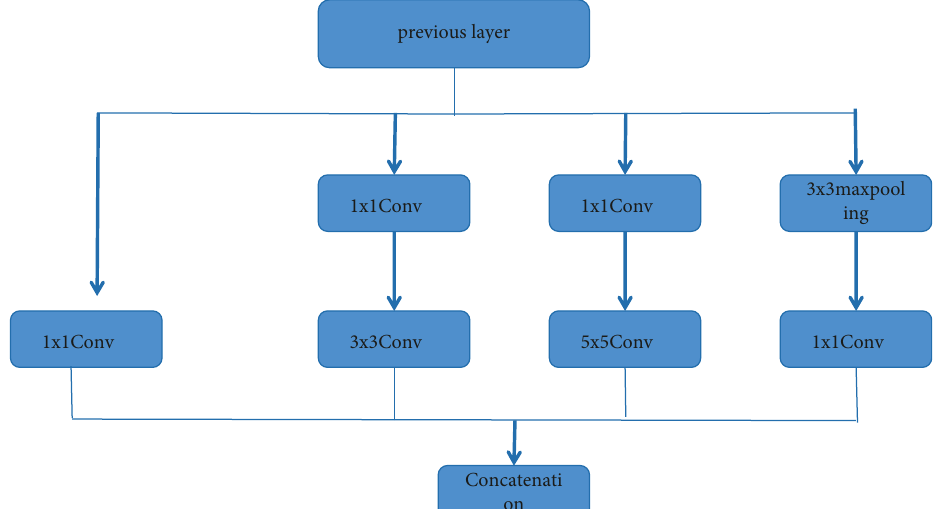
Figure 2: Structure of inception module.